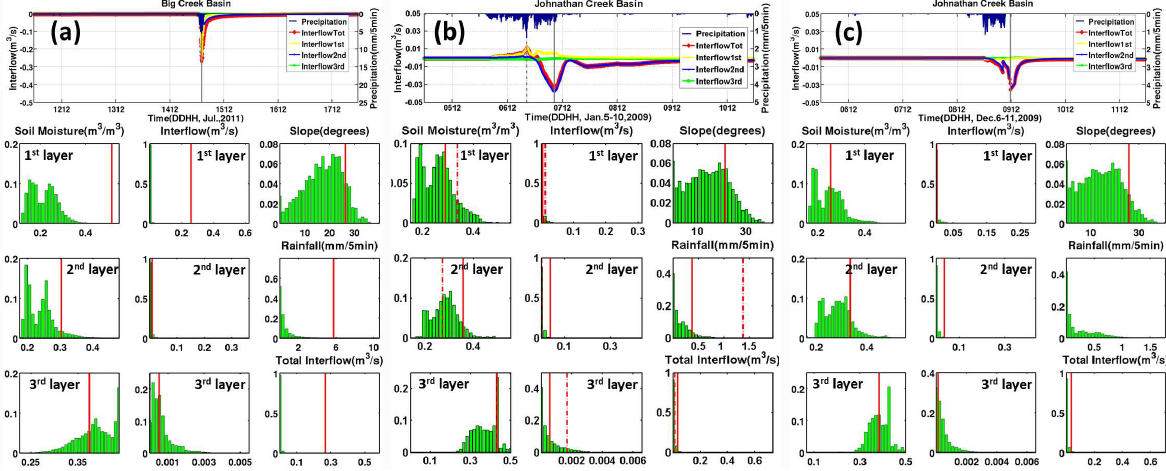
Fig. 11. The histograms of soil moisture and interflow in each soil layer, slope, rainfall rate and total interflow generated using data from all over the basin for the entire simulation period, for the event in July of 2011 (a) , and in January (b) and December (c) of 2009. The vertical red solid lines mark local conditions in the unstable grid element selected for analysis (corresponding to the gray solid line in upper interflow time series). In (b) , both the red and gray dash lines indicate the condition when the largest rainfall rate took place at the pixel but the debris flow did not occur.